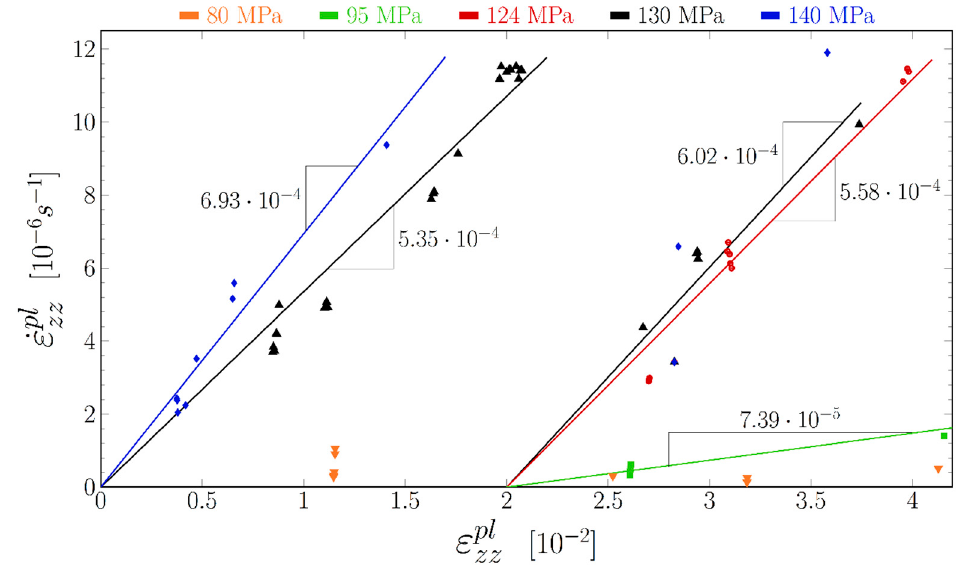
Figure 9. Strain rate of the 𝛾 channels as function of their strain for equal Von Mises stresses.